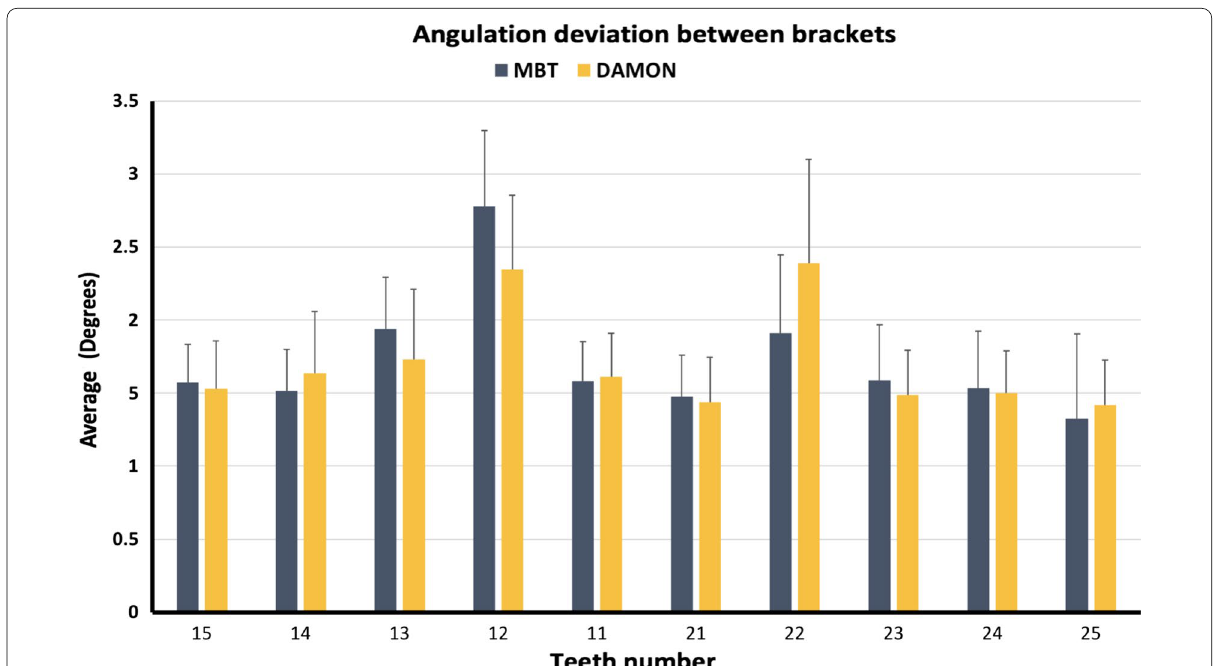
Fig. 9 Differences in angulation on each tooth between direct and indirect methods using MBT and Damon